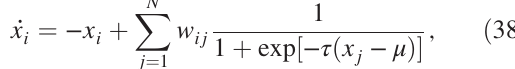
FIG. 8. (a) Schematization of the undirected network generated using the generalized preferential attachment model with ν ¼ 1 . 8 and N ¼ 60 . (b) Average neighbor activity at equilibrium as a function of its structural parameter using the degree-weighted reduction [9]. (c) Dominant eigenvector-weighted activity at equilibrium R (cid:3) ¼ v T D x (cid:3) as a function of the associated eigenvalue α for the one-dimensional reduction [Eq. (5)]. (d) Solution at equilibrium of the two-dimensional system R (cid:3) ¼ ð R (cid:3) 1 þ R (cid:3) 2 Þ = 2 as a function of the structural parameter global α α = 2 . Solid lines are results from simulations, α 1 þ 2 Þ global ¼ ð and dashed lines are theoretical predictions. Dotted lines indicate the position of the transition α . The dynamics is the SIS global model with γ ¼ 0 . 2 [Eq.